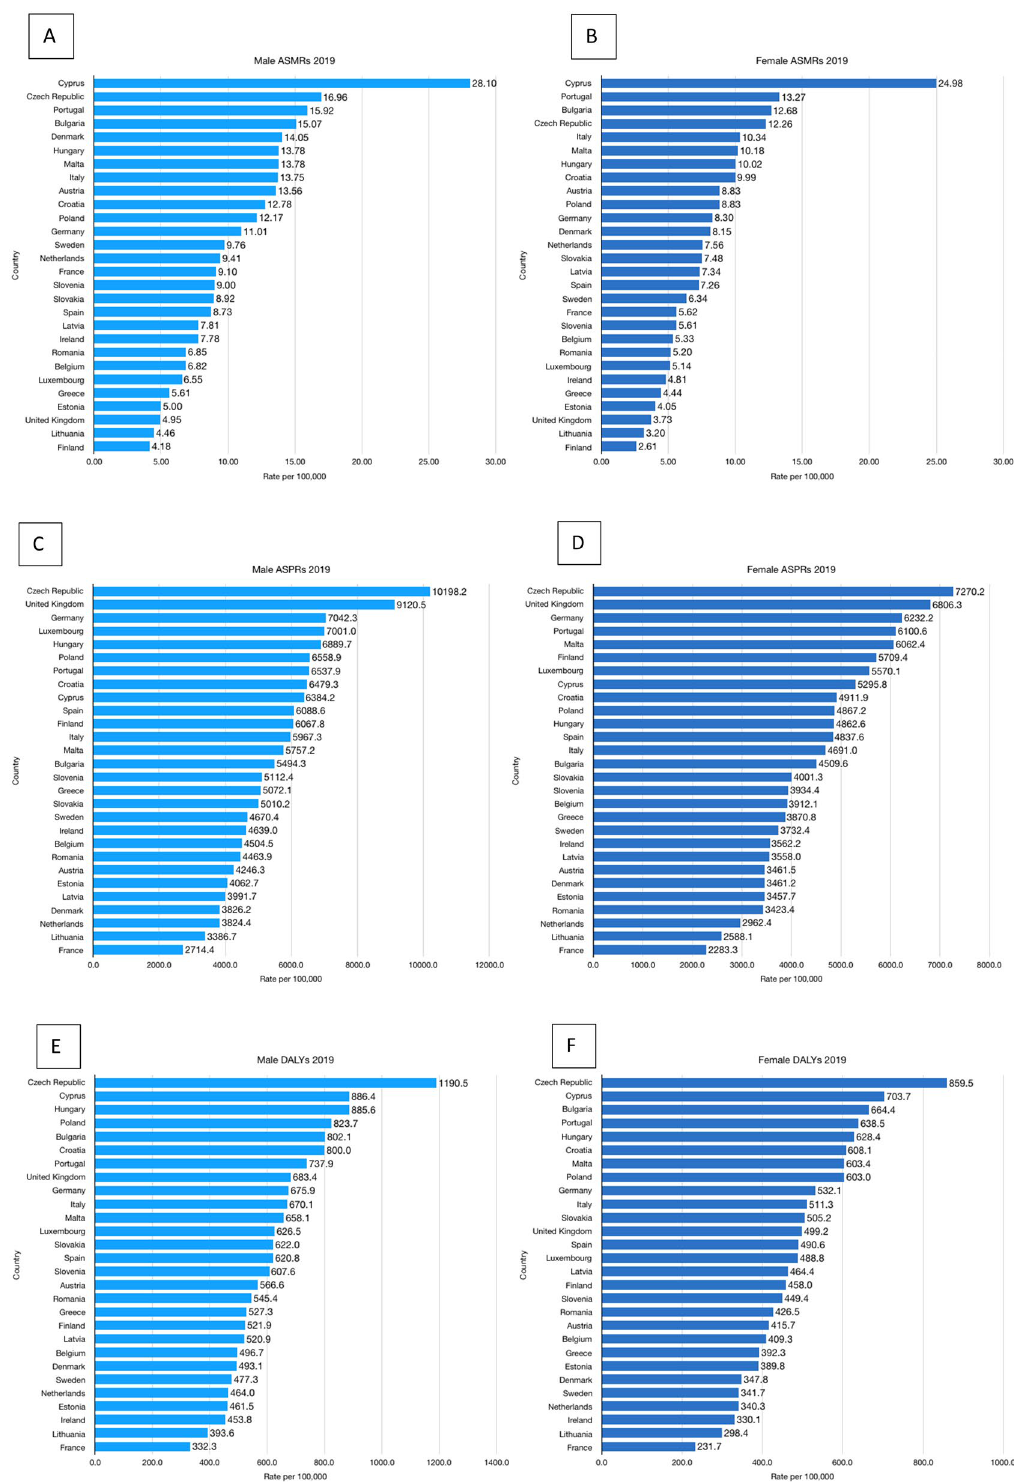
Figure 1. 2019 T2DM disease burden. 2019 age-standardised mortality rates (ASMRs) (A&B), age- standardised prevalence rates (ASPRs) (C&D) and disability-adjusted life years (DALYs) (E&F) per 100,000 population for type 2 diabetes mellitus (T2DM) in all EU countries and the